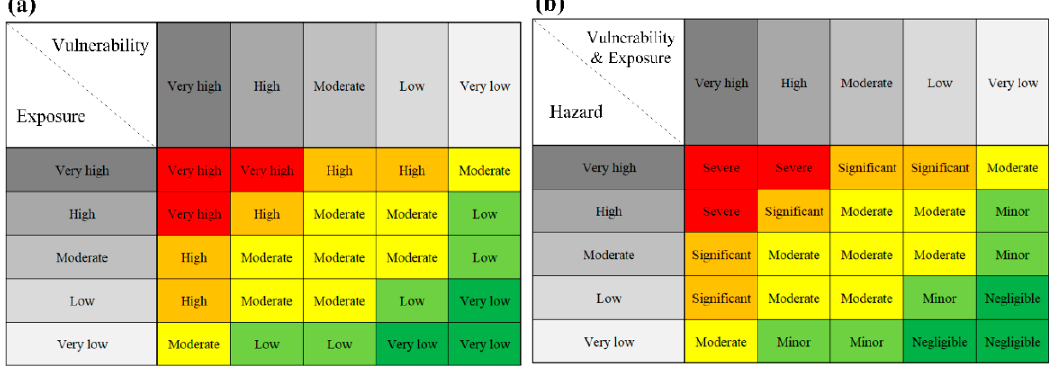
Figure 4. Level assessment matrix for ( a ) exposure and vulnerability, and risk assessment matrix for ( b ) levels of hazard, exposure, and vulnerability.